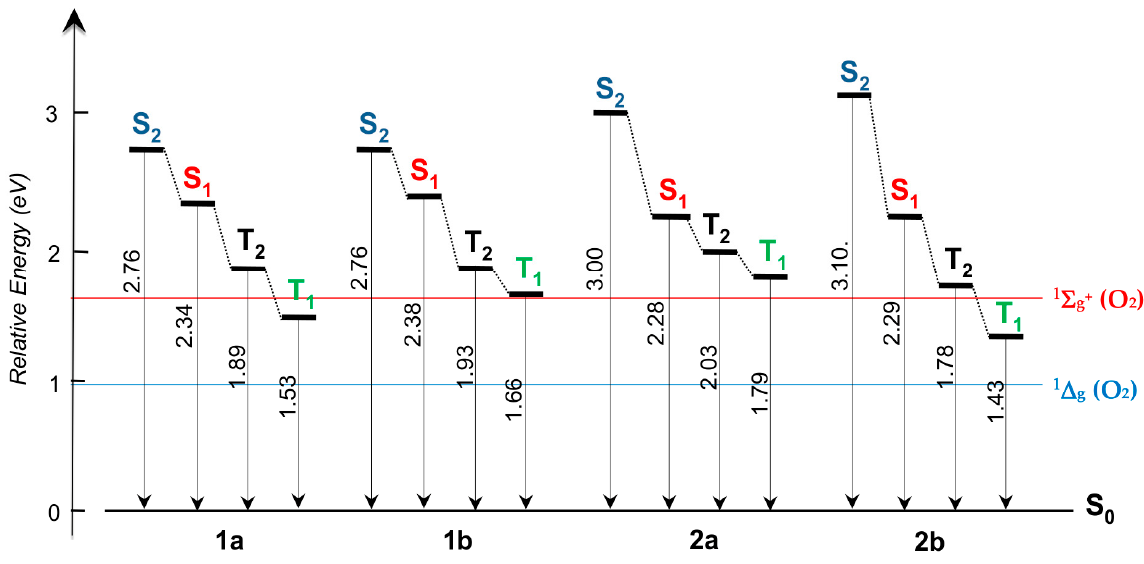
Figure 8. Relative energies (eV) of the excited states S 1 , S 2 , T 2 and T 2 with respect to that of S 0 for 1a , b and 2a , b (the most stable conformer a ) computed at the CAM-B3LYP/6-31 + G(d) level in toluene. The energy of the two lowest-energy singlet states of molecular oxygen is indicated by the red and blue lines.